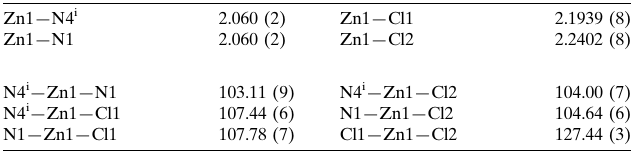
Selected geometric parameters (A˚ , (cid:1)